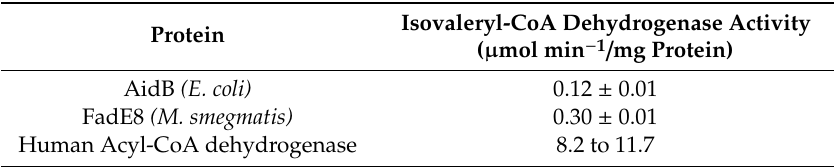
Table 1. Enzymatic activity of recombinant FadE8 in comparison with E. coli AidB and human Acyl-CoA